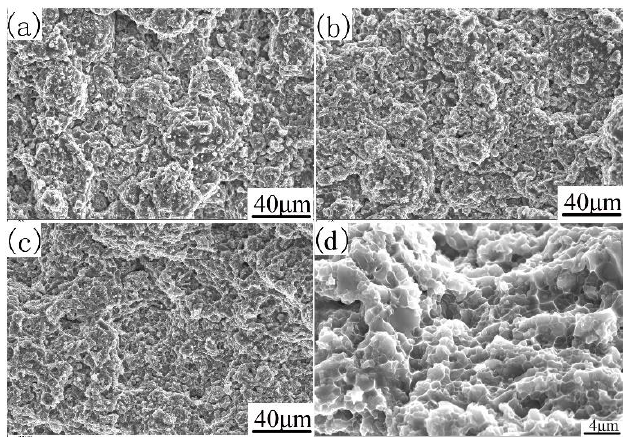
Figure 9. SEM/SE of the fracture surface of sintered samples. With different compaction velocities ( a ) 6.2 ms − 1 , ( b ) 7.9 ms − 1 , ( c ) and ( d ) 9.4 ms −